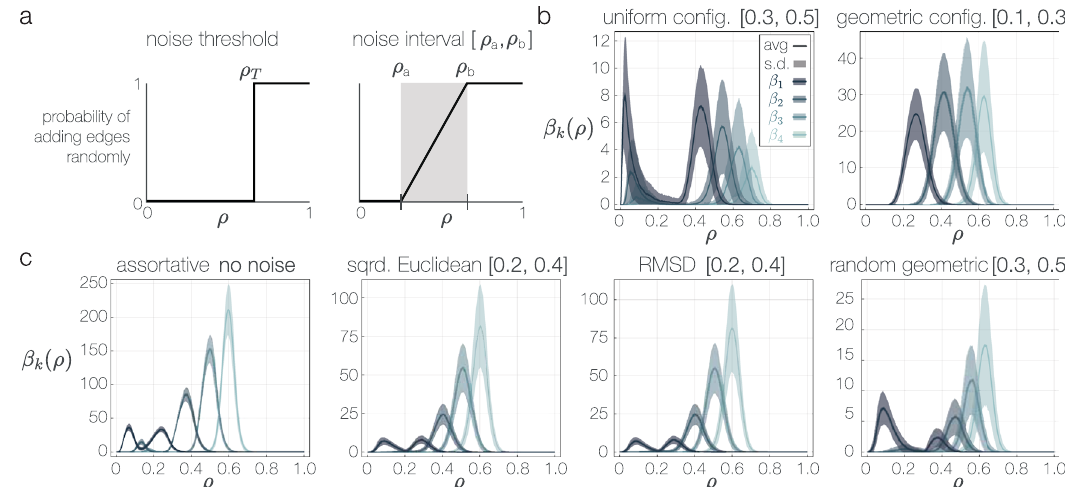
Fig. 6 Noise overlapping real networks can complicate interpretations of network structure. a Previous experiments used a sharp edge density threshold ρ fi ltering on edge density ρ , but a more realistic scenario is to have an increasing likelihood of noisy edges over T to separate model from noise edges when some interval [ ρ a , ρ b ]. Betti curves from the uniform con fi guration model with noise interval [0.3, 0.5] and the geometric con fi guration model with noise interval [0.1, 0.3]. c Betti curves for the assortative model with no noise added, squared Euclidean model with noise interval [0.2, 0.4], root mean squared deviation (RMSD) model with noise interval [0.2, 0.4], and random geometric model with noise interval [0.3, 0.5]. See panel b for